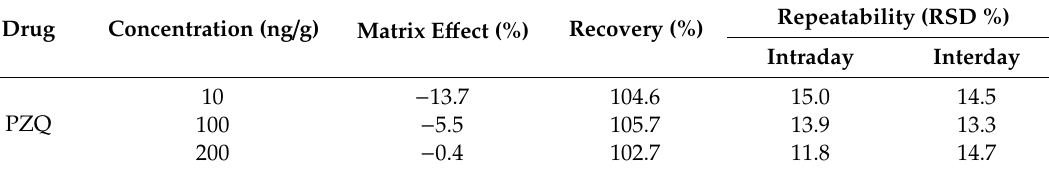
Table 3. Matrix e ff ect, recovery and precision.